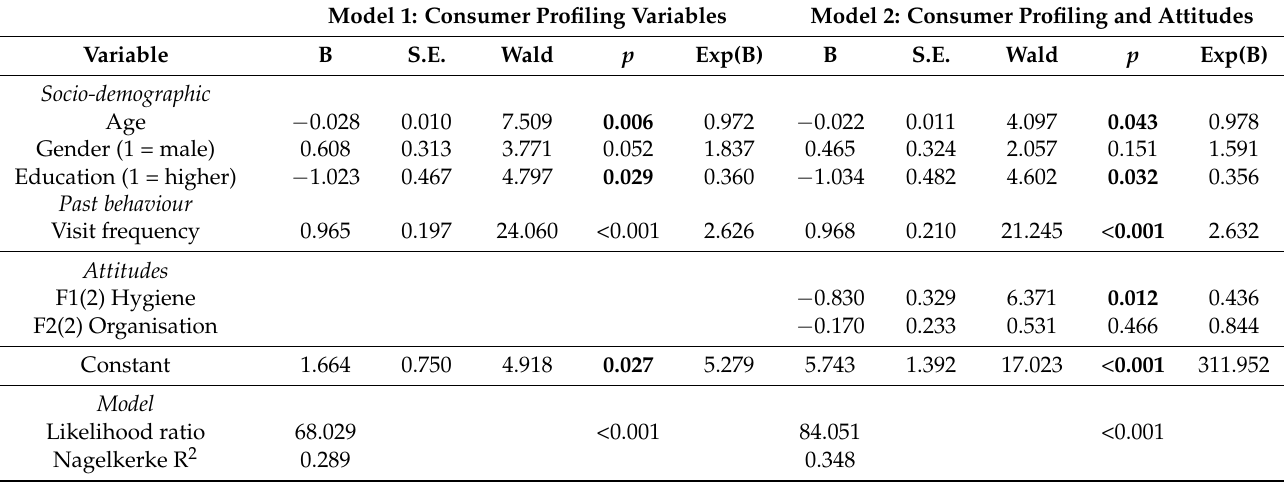
Table 6. Coefficient estimates and diagnostics from hierarchical binary logistic regression explaining consumers’ revisit behaviour (study 2; n = 301